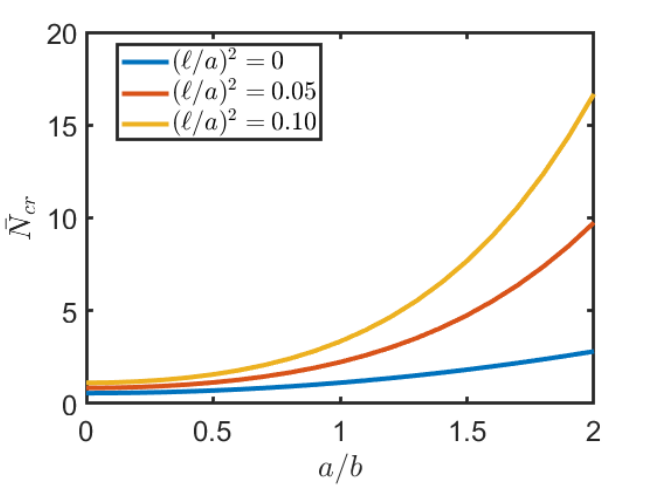
Figure 4. Critical load ¯ N cr of square FG nanoplate for different values of ratio a / b and different values of non local parameter ( (cid:96) / a ) 2